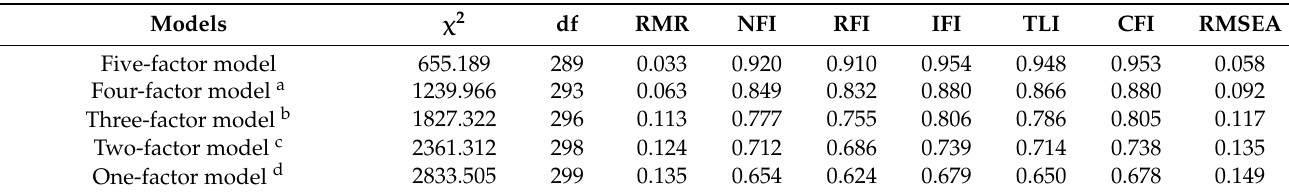
Table 3. Fitting degree of competition